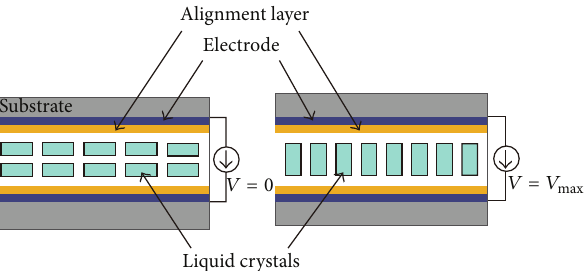
Figure 3: Working principle diagram of the nematic liquid